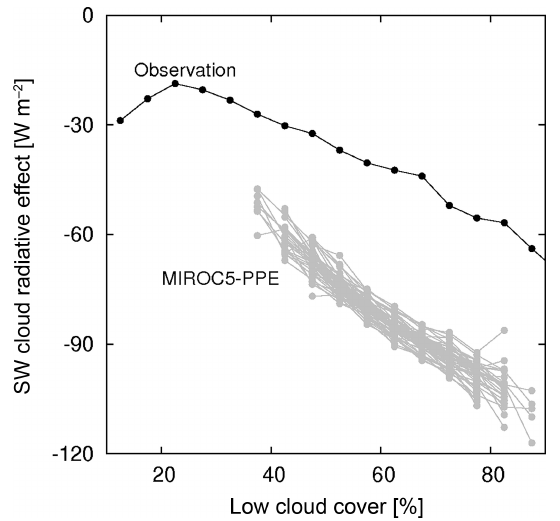
Figure 6. Relationship between the non-overlapped low cloud amount and shortwave CRE of the July mean for the Hawaiian Trade Cumulus